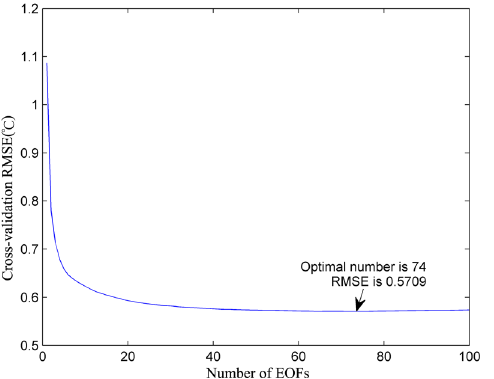
Fig 8. RMSEs obtained with cross-validation for reconstruction by using DINEOF algorithm.